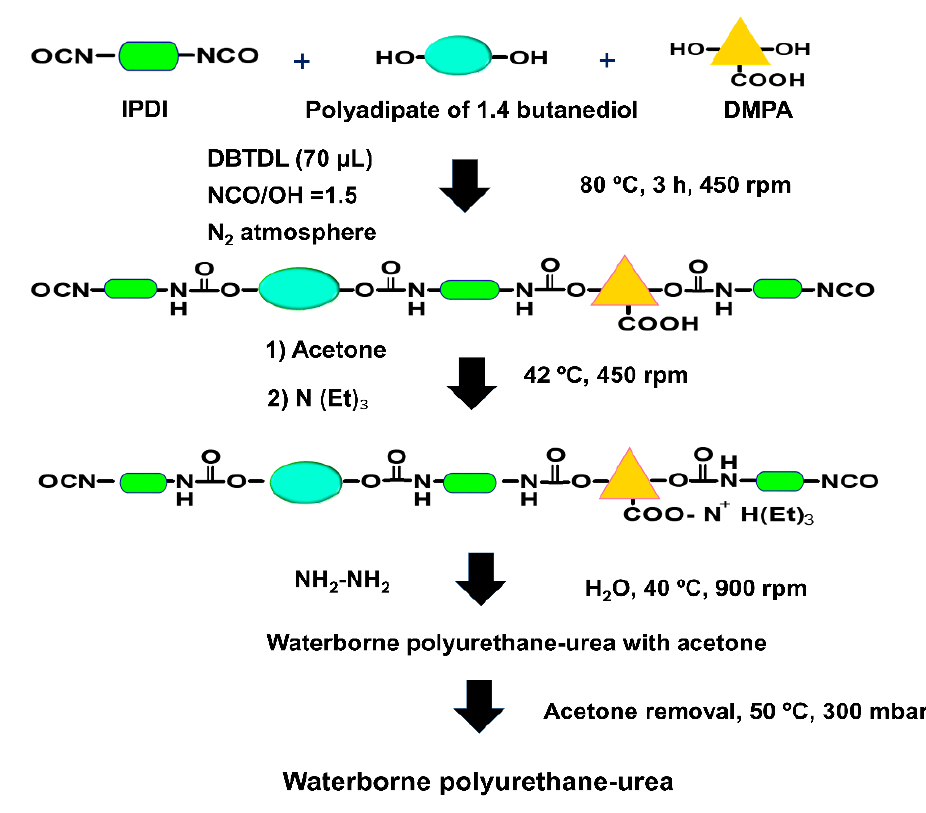
Figure 1. Scheme of the synthesis of the waterborne poly(urethane urea) dispersion.